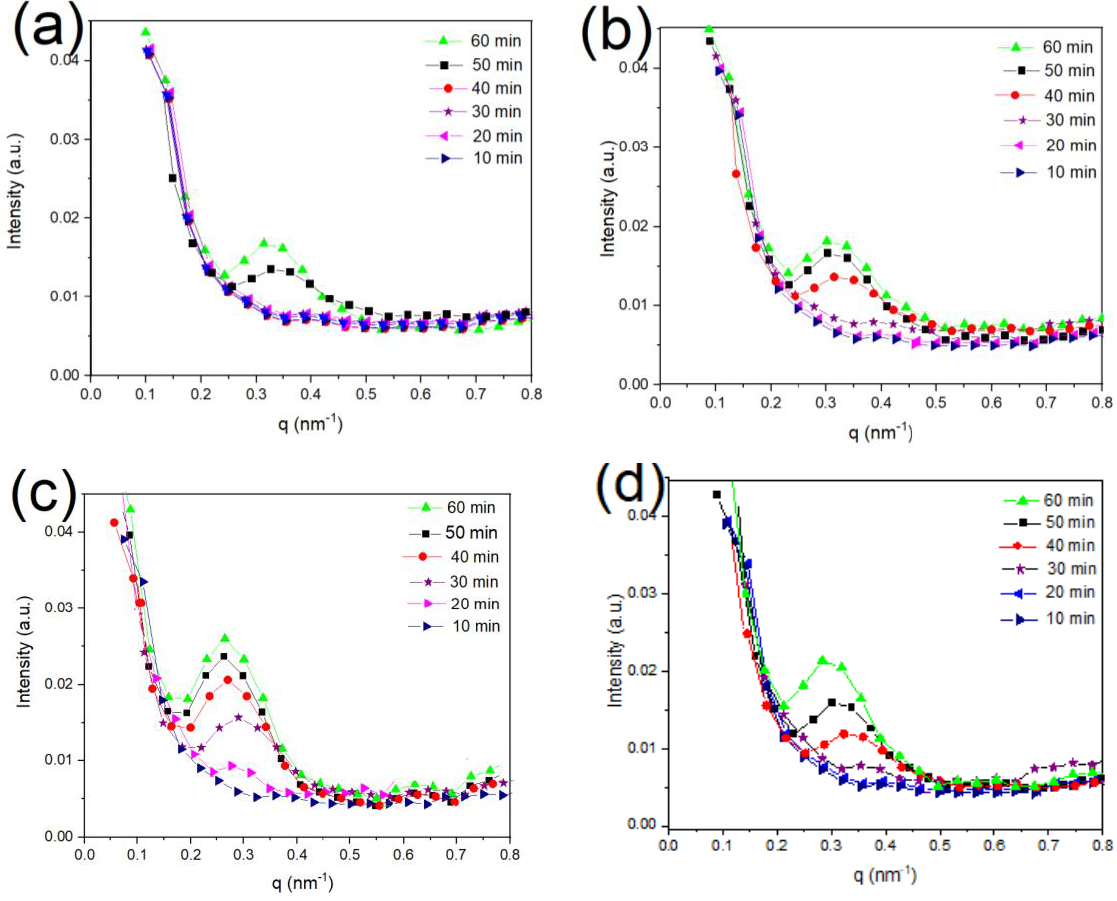
Figure 5. The SAXS analysis of ( a ) neat PLA, ( b ) PLA/g-SNC (3 wt%), ( c ) PLA/g-SNC (5 wt%), and ( d ) PLA/g-SNC (7 wt%) nanocomposites which are crystallized for different crystallization times at T c = 130 °𝐶 .